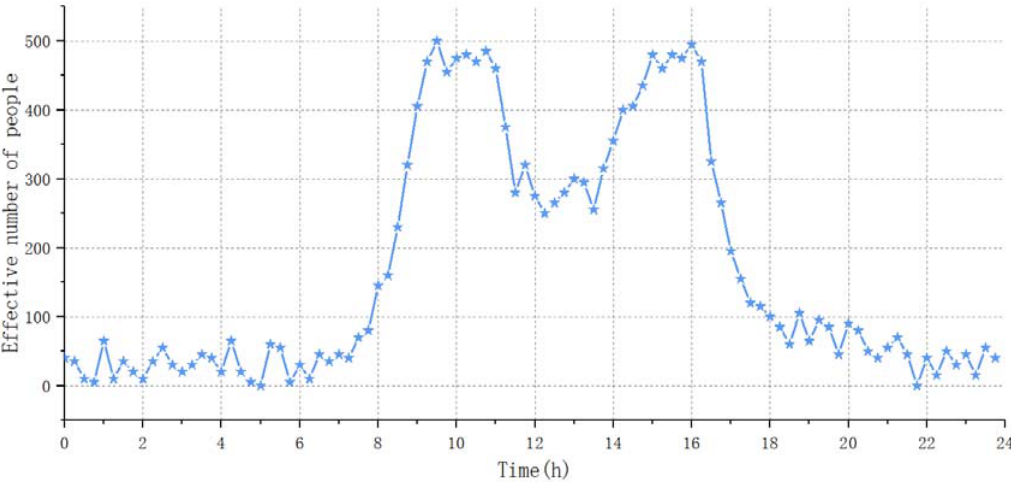
Figure 7. Distribution of effective number of people on a working day.